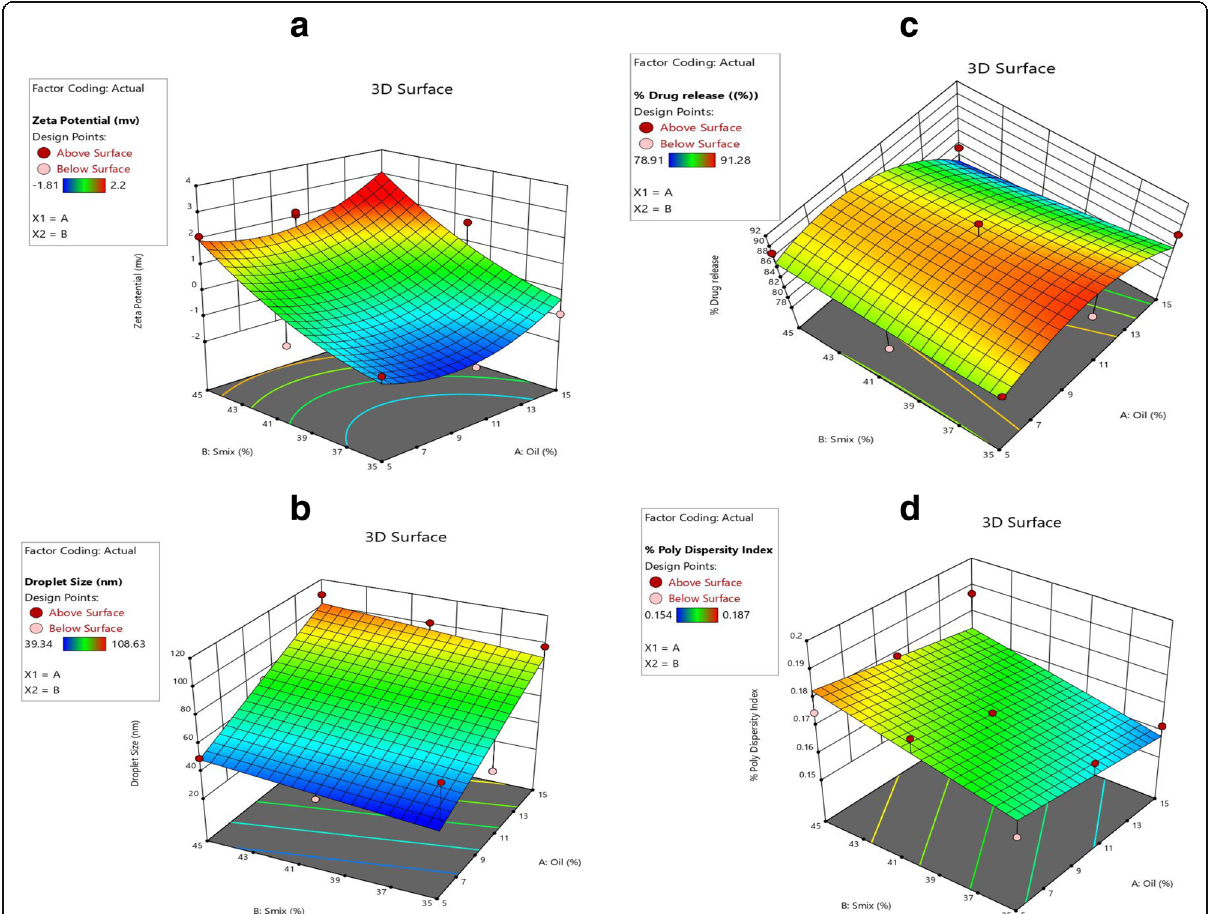
Fig. 2 a Response surface plot of zeta potential (mv). b Response surface plot of droplet size (nm). c Response surface plot of percent drug